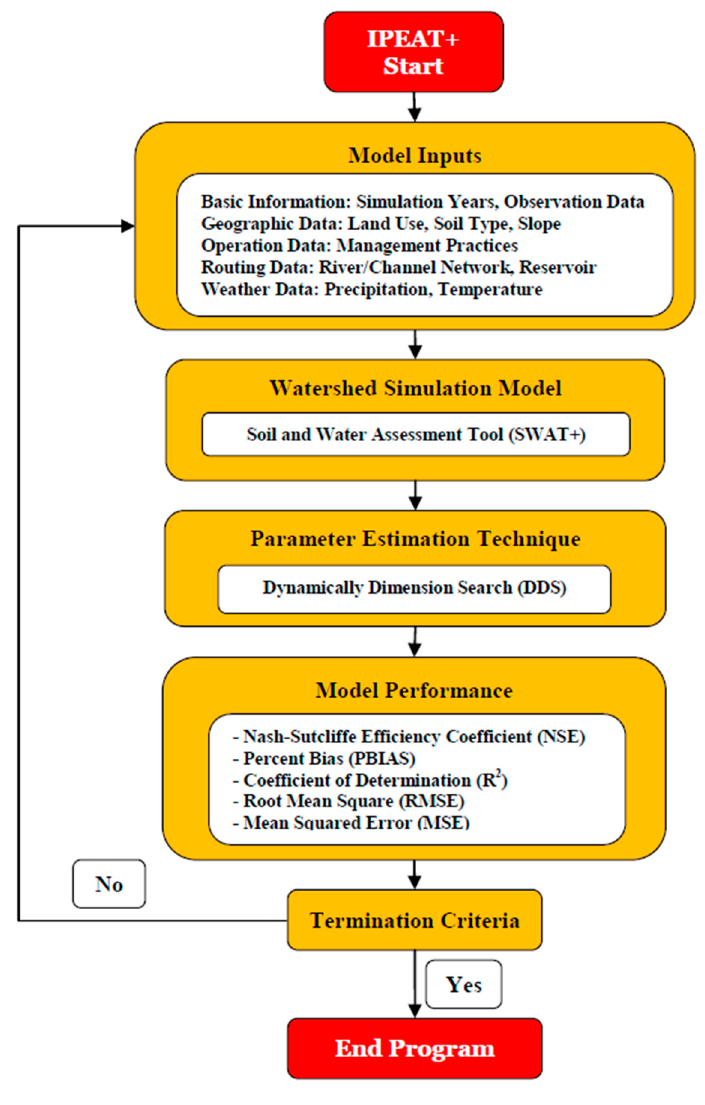
Figure 1. Computational framework of IPEAT + with SWAT + in watershed modeling .